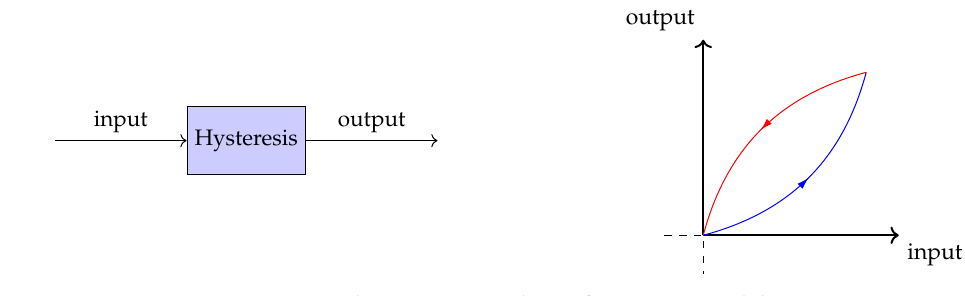
Figure 1. Typical input-output relation for a system with hysteresis.